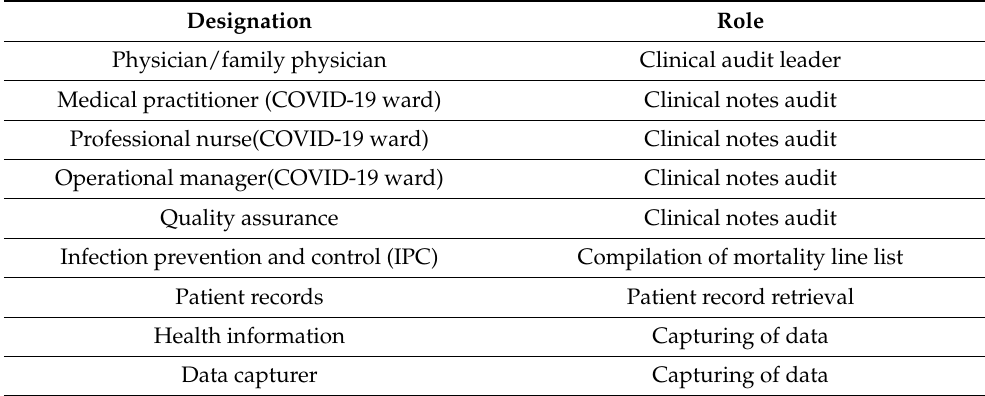
Table 1. Hospital audit